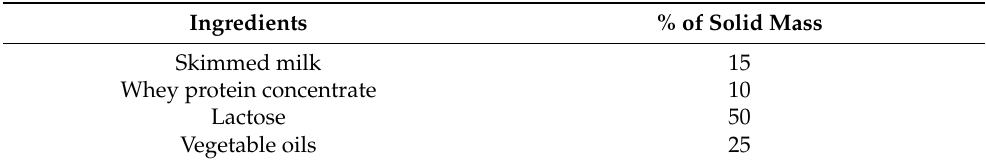
Table 1. Assumed baseline recipe used to produce powdered infant formula, based on Karlsson et al. (2019) [27]. Ingredients % of Solid Mass Skimmed milk 15 Whey protein concentrate 10 Lactose 50 Vegetable oils